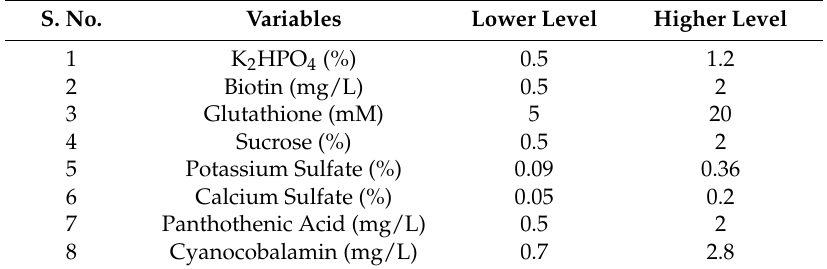
Table 2. The assigned concentrations of variables at different levels in the Fractional factorial design for Fab